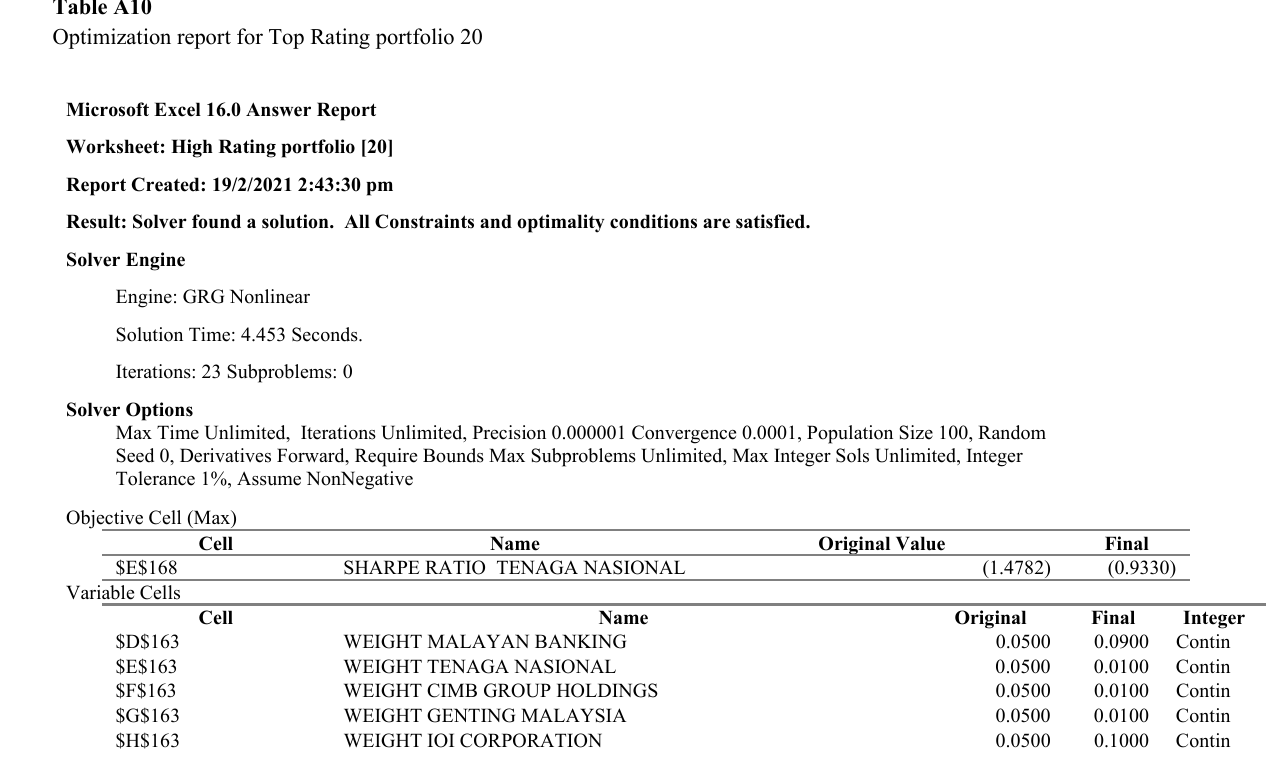
Table A10 Optimization report for Top Rating portfolio